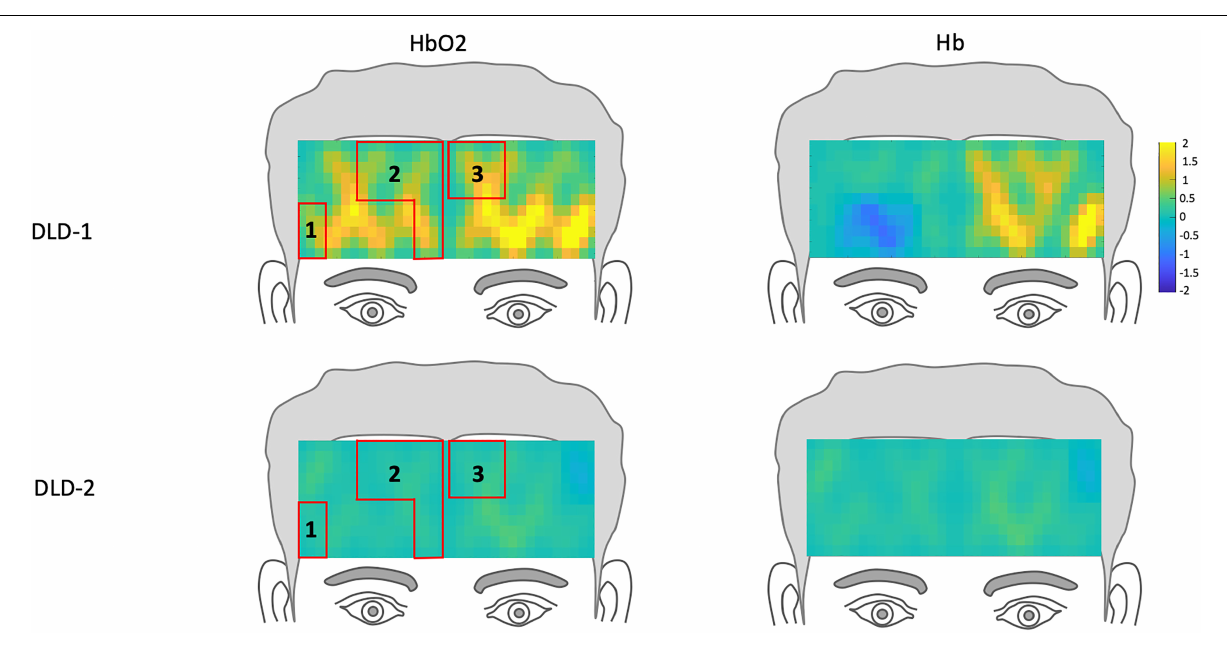
FIGURE 4 | Z -score topographs for DLD-1 and DLD-2 from pre-training, for high-frequency words for HbO 2 and Hb. ROIs established by the normal controls are outlined in